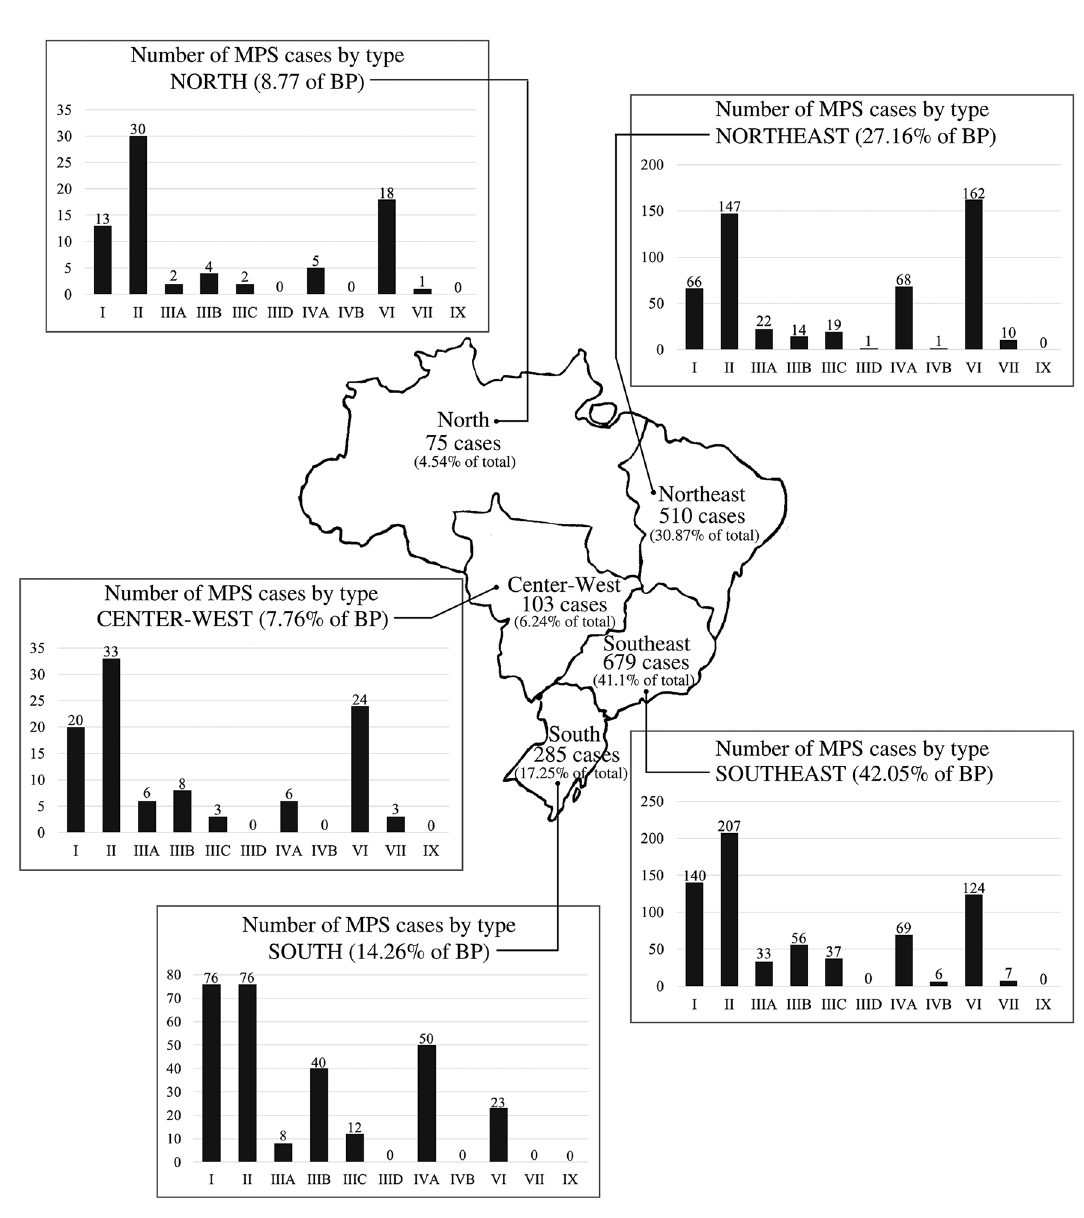
Figure 1 – Distribution according to Brazilian region of the Brazilian MPS cases diagnosed at the Medical Genetics Service of Hospital de Clínicas de Porto Alegre from 1982 to 2019 (BP: Brazilian population as estimated in 2019) (IBGE, 2020).